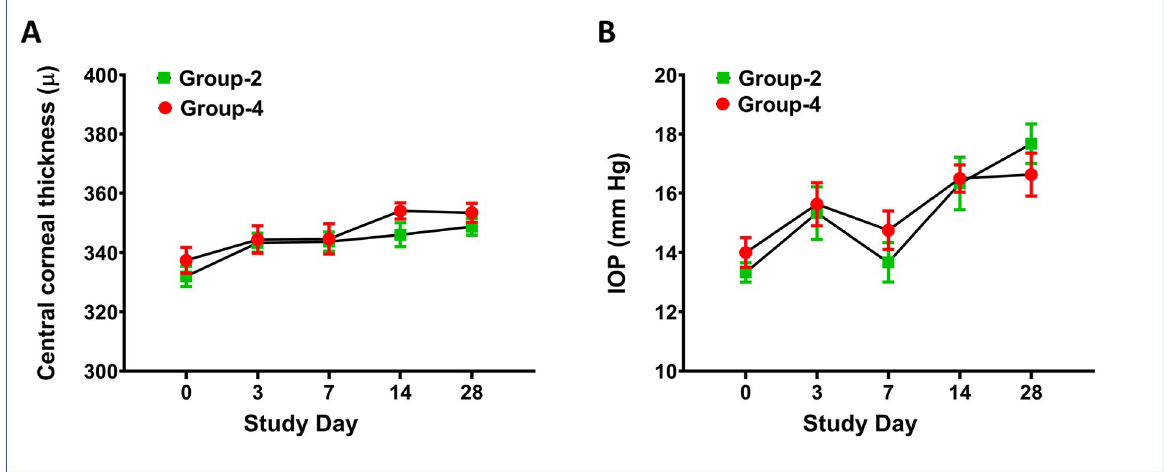
Fig 2. In vivo tolerability evaluation showing central corneal thickness and intraocular pressure. No significant difference in central corneal thickness (A) or intraocular pressure (B) in the na ï ve eyes of Group-2 and unwounded eyedrop-treated eyes of Group-4 was observed until 28 days (n = 6 for each